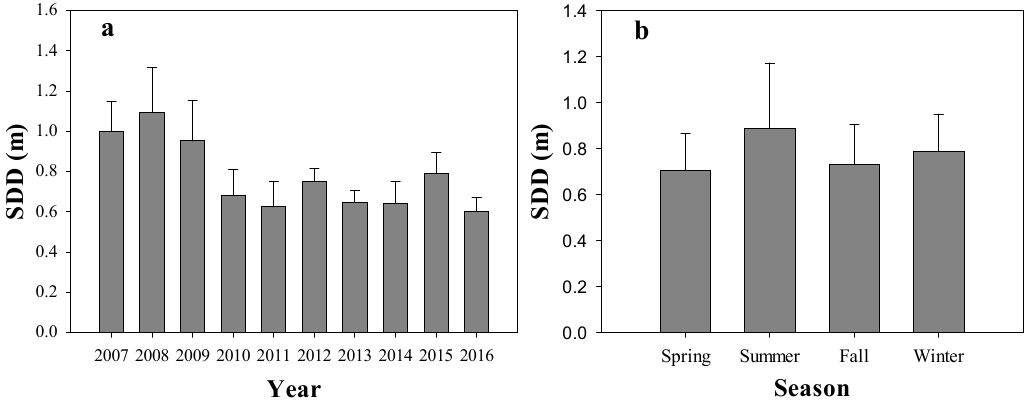
Figure 4. The ( a ) annual mean SDD and ( b ) seasonal mean SDD in Lake Liangzi.